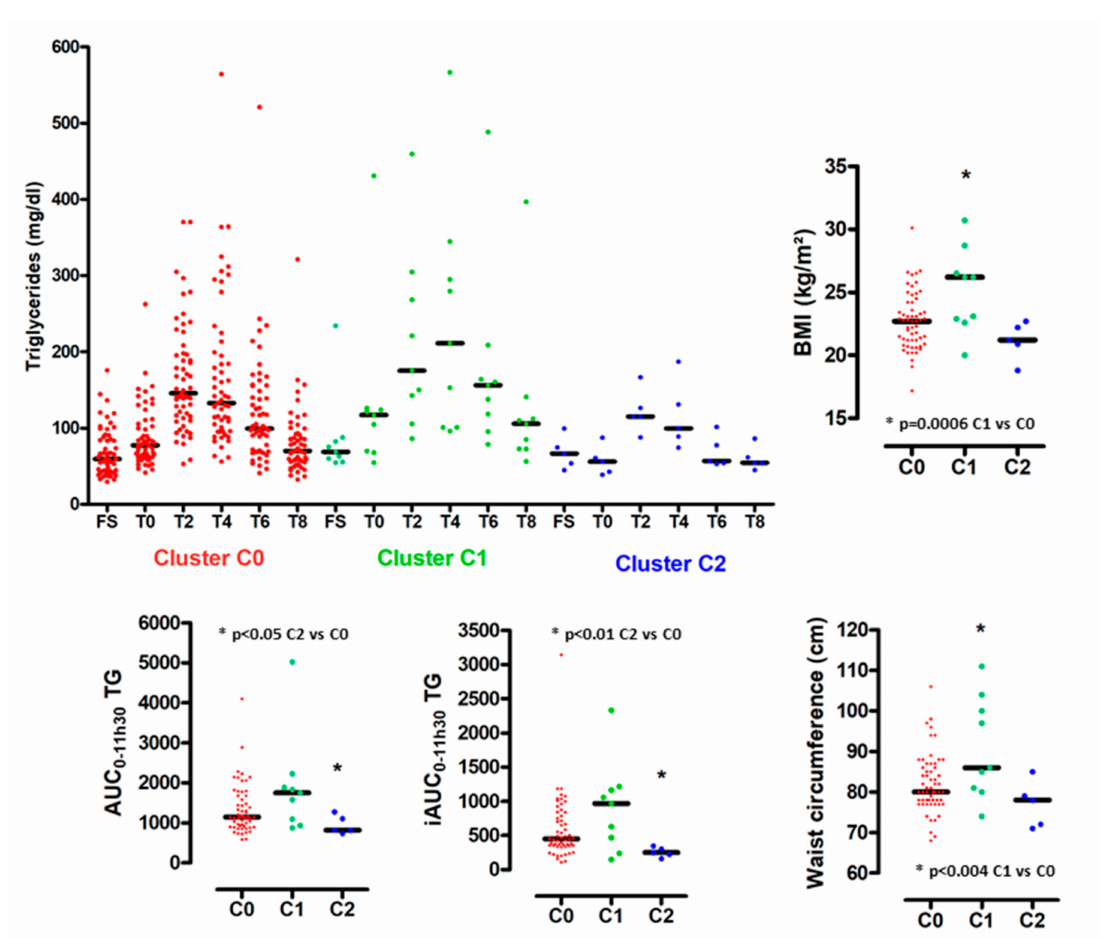
Figure 5. Biological signatures associated with postprandial bile acid profiles. Distribution of plasma triglyceride levels according to postprandial time course in subjects from cluster C0, C1 and C2. (left upper panel). Distribution of AUC 0-11h30 –TG, iAUC 0-11h30 -TG BMI and waist circumference in subjects from cluster C0, C1 and C2. Black bars indicate